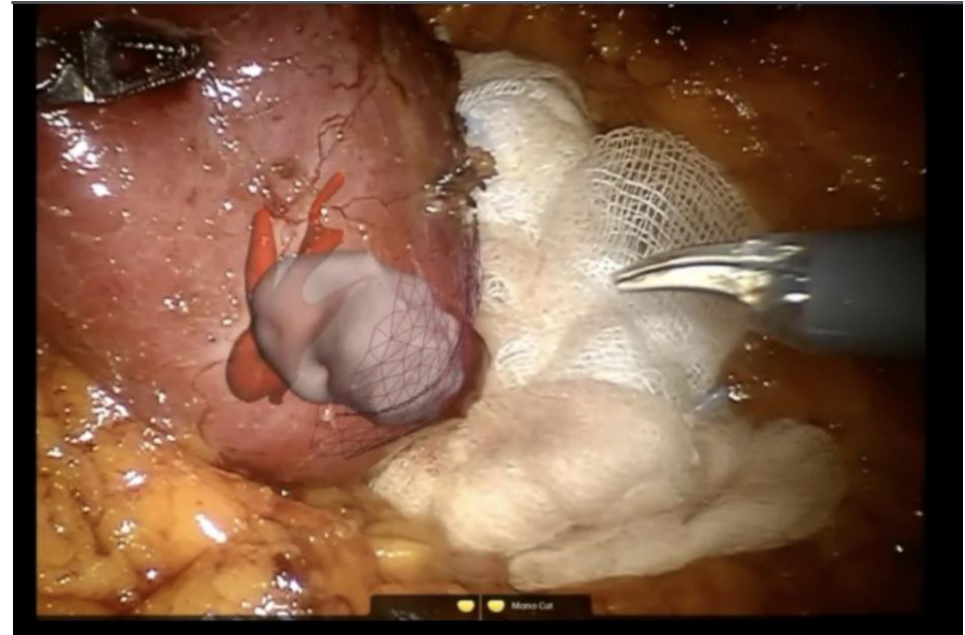
Figure 8. Augmented reality (AR) for partial nephrectomy (robotic surgery). Renal arteries (red) and renal tumor (grey-white) (EnCoV, SurgAR, Clermont-Ferrand, France).